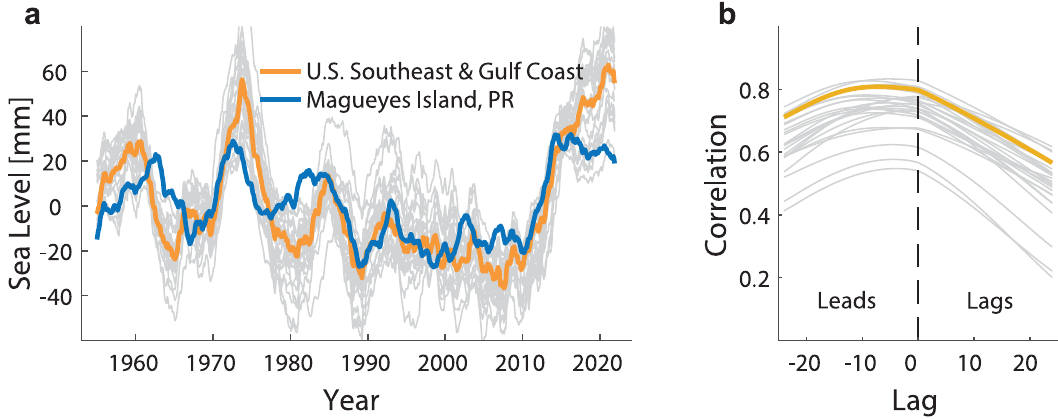
Fig. 5 | Comparison between mean sea level (MSL) variability along the U.S. SoutheastandGulfcoastsandtheCaribbeanSea.a Individuallinearlydetrended tide gauge records overtheir overlapping periodfrom 1955to 2021. All timeseries